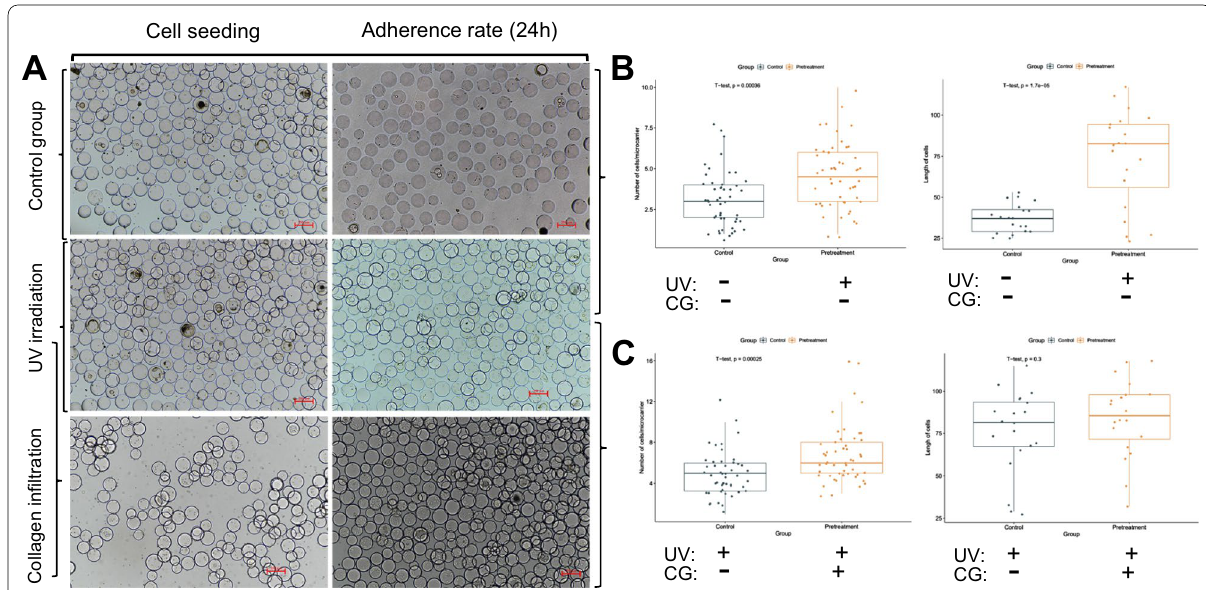
Fig. 1 Effect of cell pretreatment on cell attachment and proliferation. A Control, UV irradiation, and collagen infiltration three groups of cell inoculation status and 24 h attachment efficiency results. B Comparison results of cell attachment efficiency between the control group and the UV treatment group. C UV and/or CG treatment compares the results of cell attachment efficiency with the control